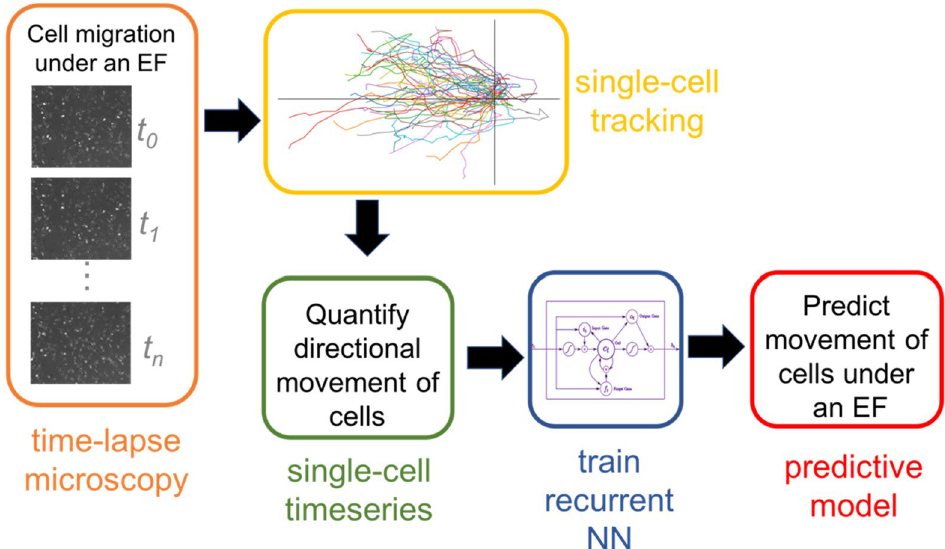
Figure 1. The image processing and cell directedness prediction pipeline. Time-lapse microscope images are used to manually track a number of cells. The tracking data is used to create timeseries of our two features (cell directedness and EF), which are used as inputs to our blackbox LSTM model to make predictions about the next directedness